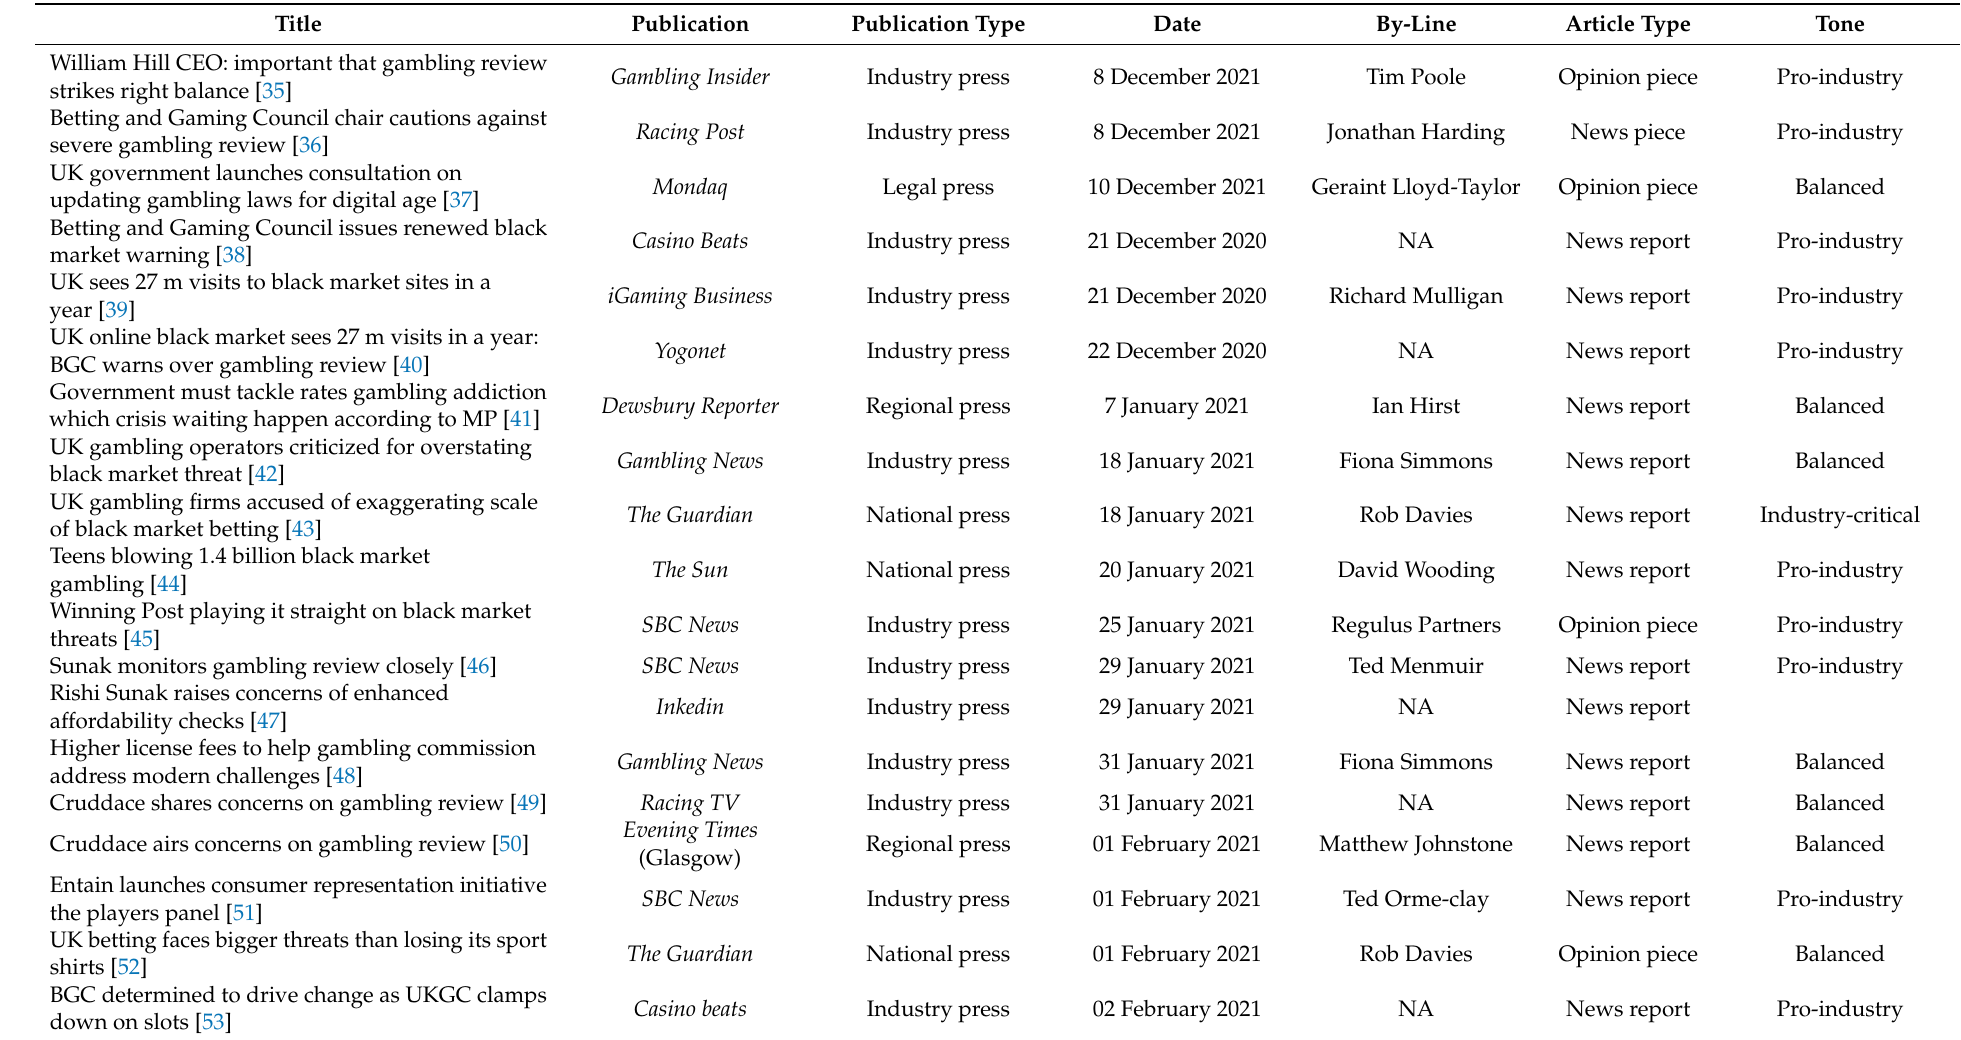
Table 1. Summary of articles included in the